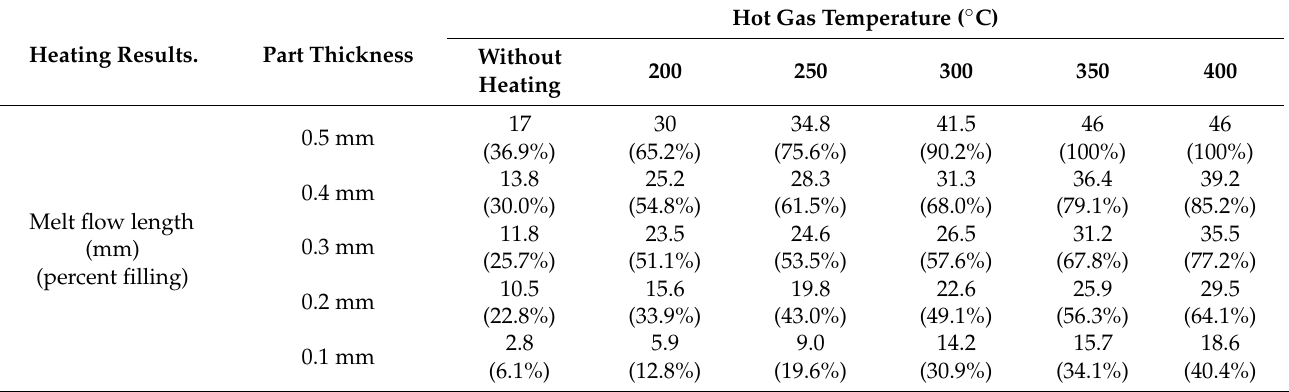
Table 3. The experimental results of an internal gas-assisted mold temperature control (In-GMTC) for the melt flow length of polyamide 6 reinforced with 30 wt.% glass fiber (PA6/GF30%).